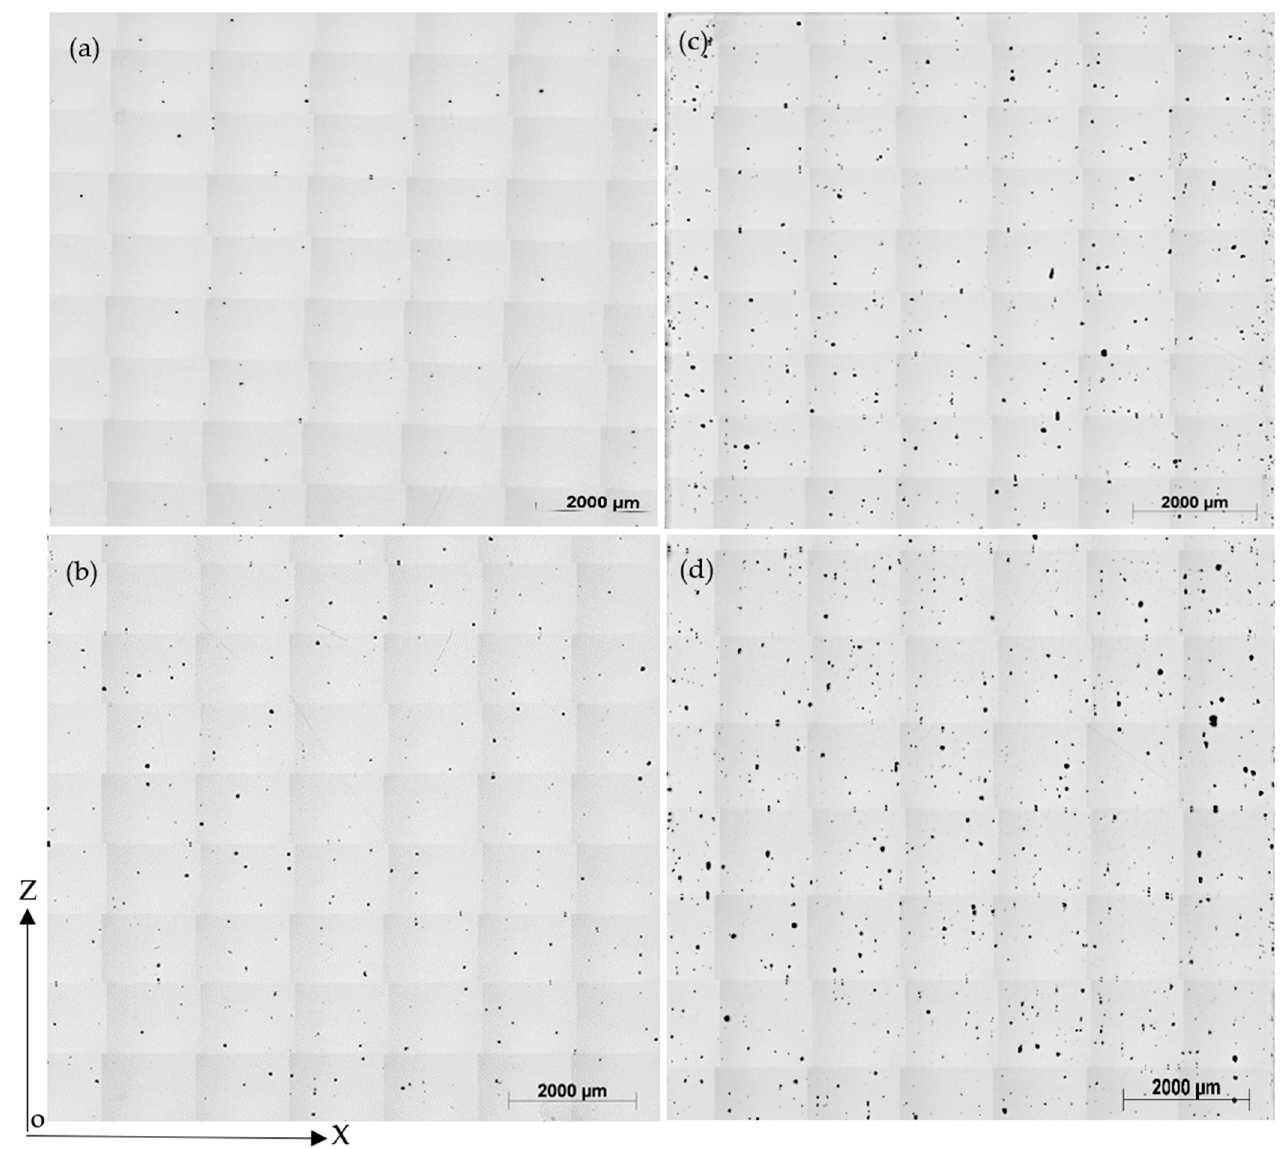
Figure 10. The variation of porosity level with island size for the same energy density, ( a ) Ev of 85 J/mm 3 , IS = 6.5 mm, Af = 0.07%; ( b ) Ev of 85 J/mm 3 , IS = 3.5 mm, Af = 0.29%; ( c ) Ev of 158 J/mm 3 , IS = 6.5 mm, Af = 0.71%; ( d ) Ev of 158 J/mm 3 , IS = 3.5 mm, Af = 1.04.